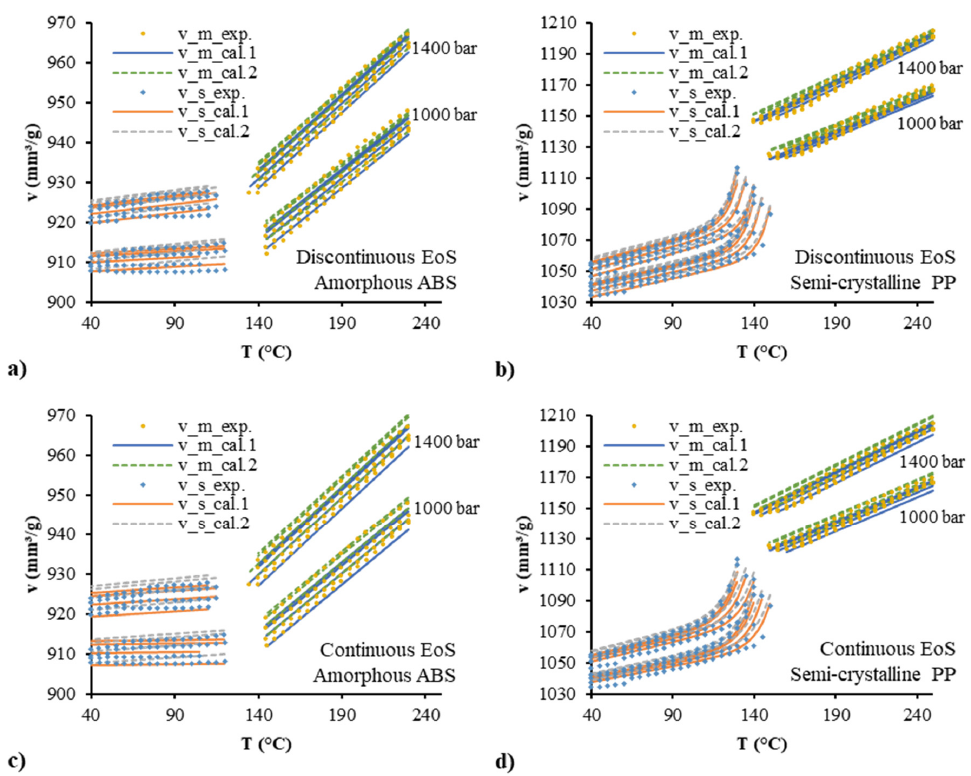
Figure 9. Validation of the discontinuous two-domain EoS for amorphous ABS ( a ) and semi-crystalline PP ( b ) and the continuous two-domain EoS for amorphous ABS ( c ) and semi-crystalline PP ( d ) with the additional pvT data at two isobaric levels of 1400 and 1000 bar.